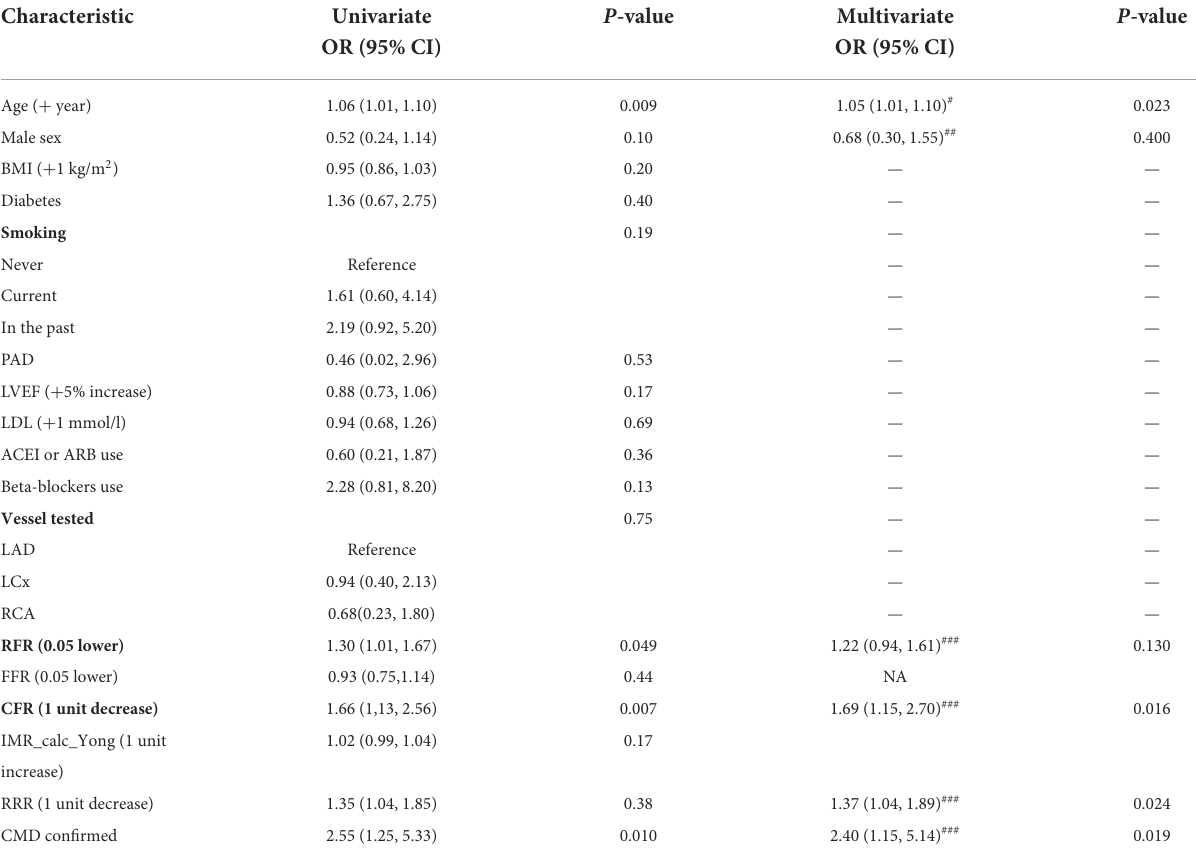
TABLE 3 Univariate and multivariate regression analysis of RFR/FFR discordance predictors.